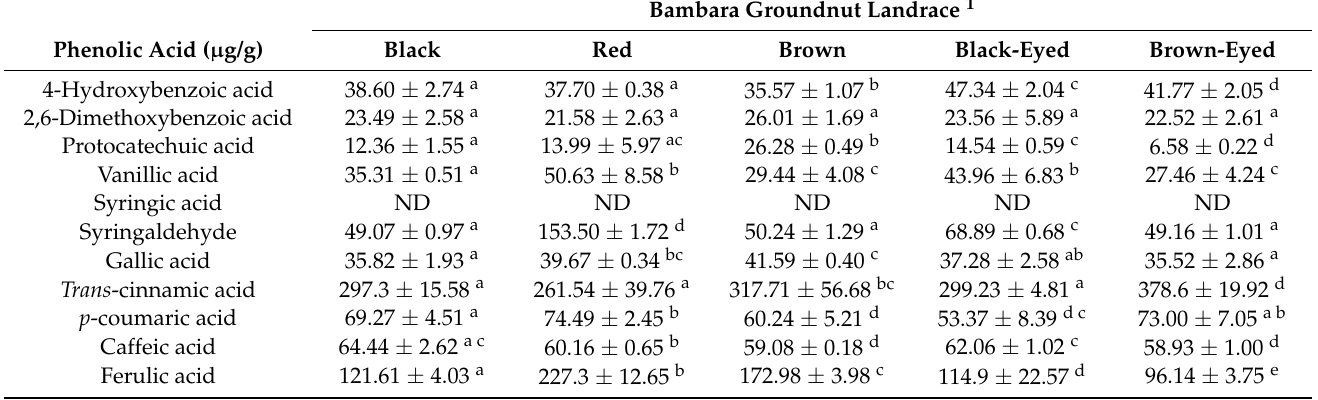
Table 4. Phenolic acid composition of the ethanolic extracts of the cotyledons of various Bambara groundnut